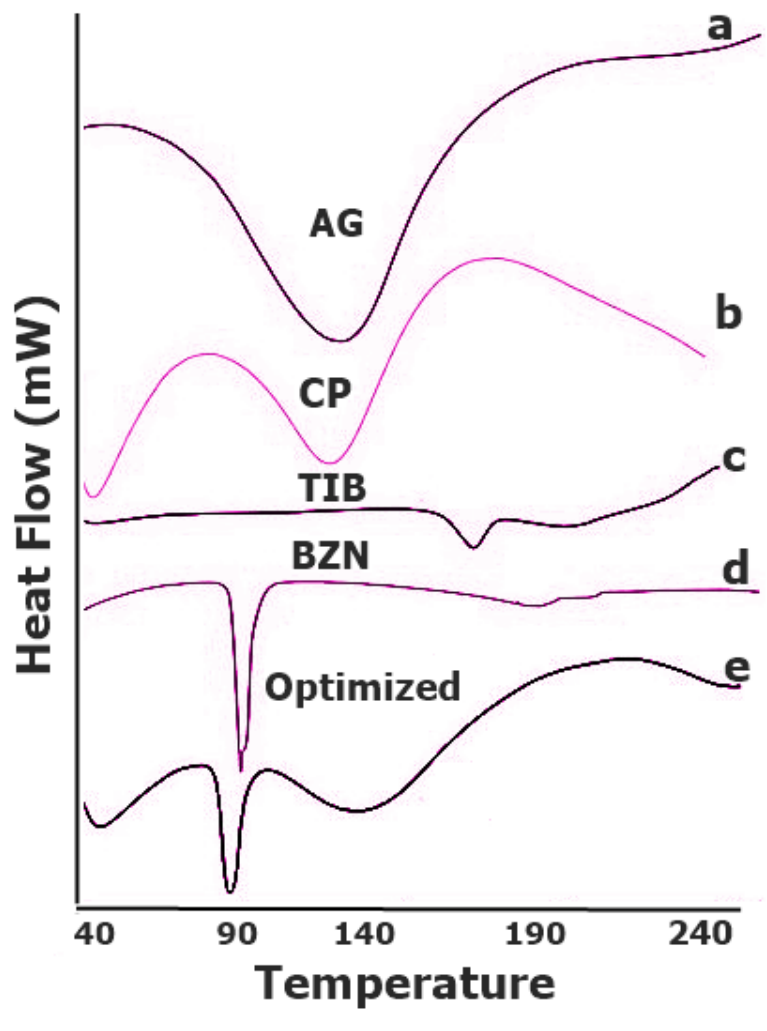
Figure 6. DSC peaks of ( a ) AG, ( b ) CP, ( c ) TIB, ( d ) BZN, and ( e ) physical mixture.